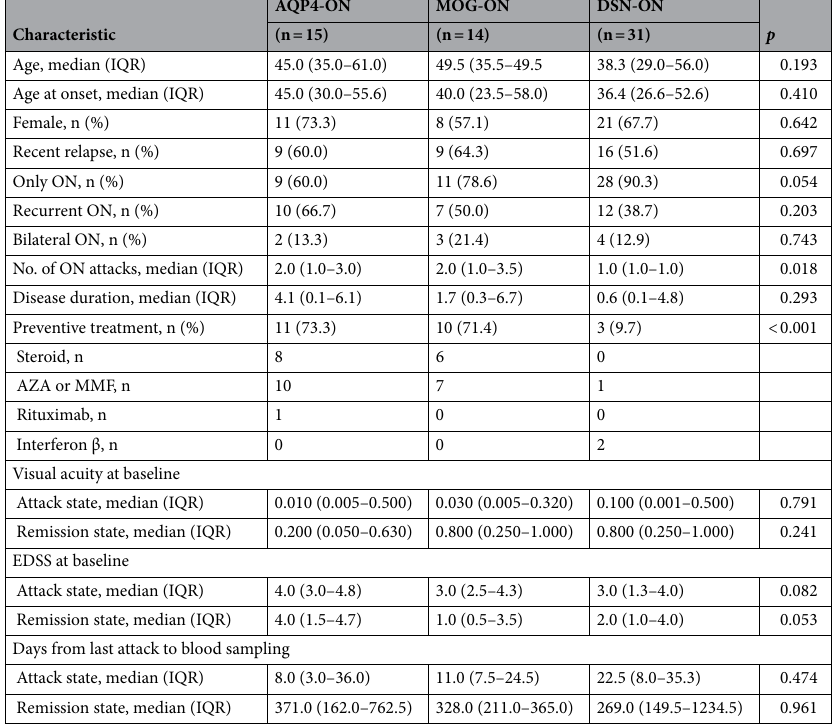
Table 1. Patient baseline characteristics at enrollment. AQP4-ON optic neuritis with aquaporin-4 antibody, AZA azathioprine, DSN-ON double-seronegative optic neuritis, EDSS expanded disability status scale, IQR interquartile range, MMF mycophenolate mofetil, MOG-ON optic neuritis with myelin oligodendrocyte glycoprotein antibody, ON optic